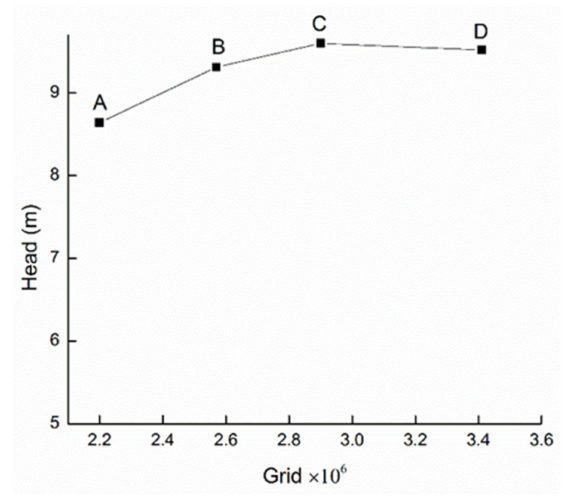
Figure 4. Grid-sensitivity analysis. Table 2. Grid-sensitivity analysis.